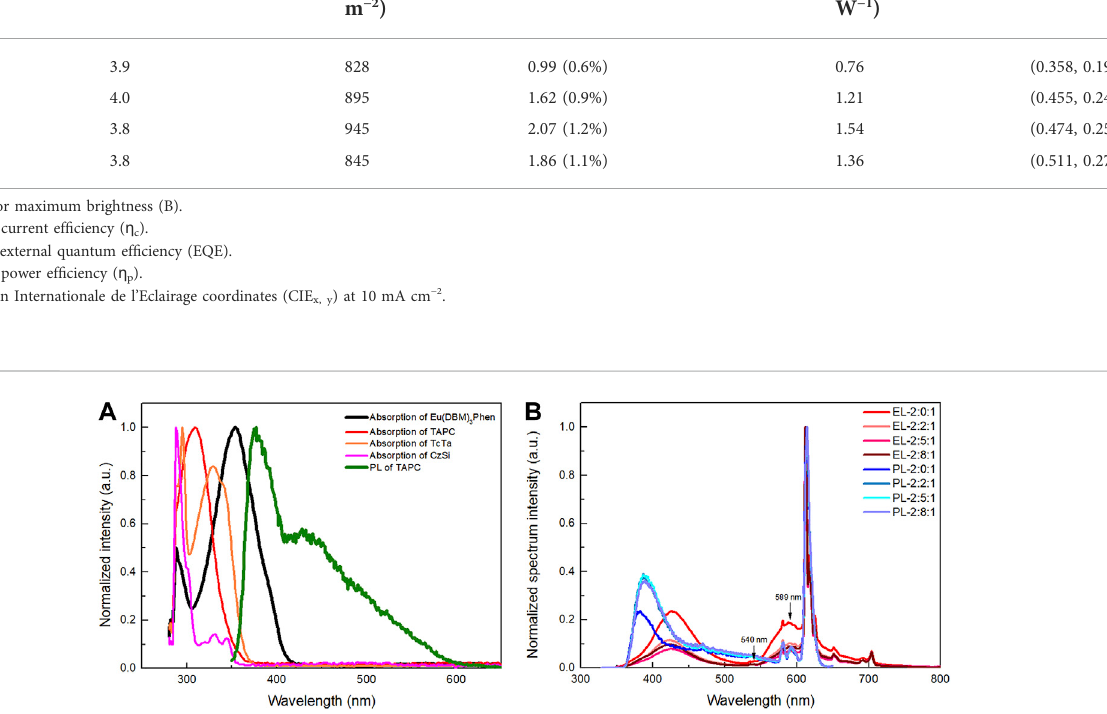
TABLE 3 The key properties of devices with TAPC:TcTa:CzSi at different ratios.